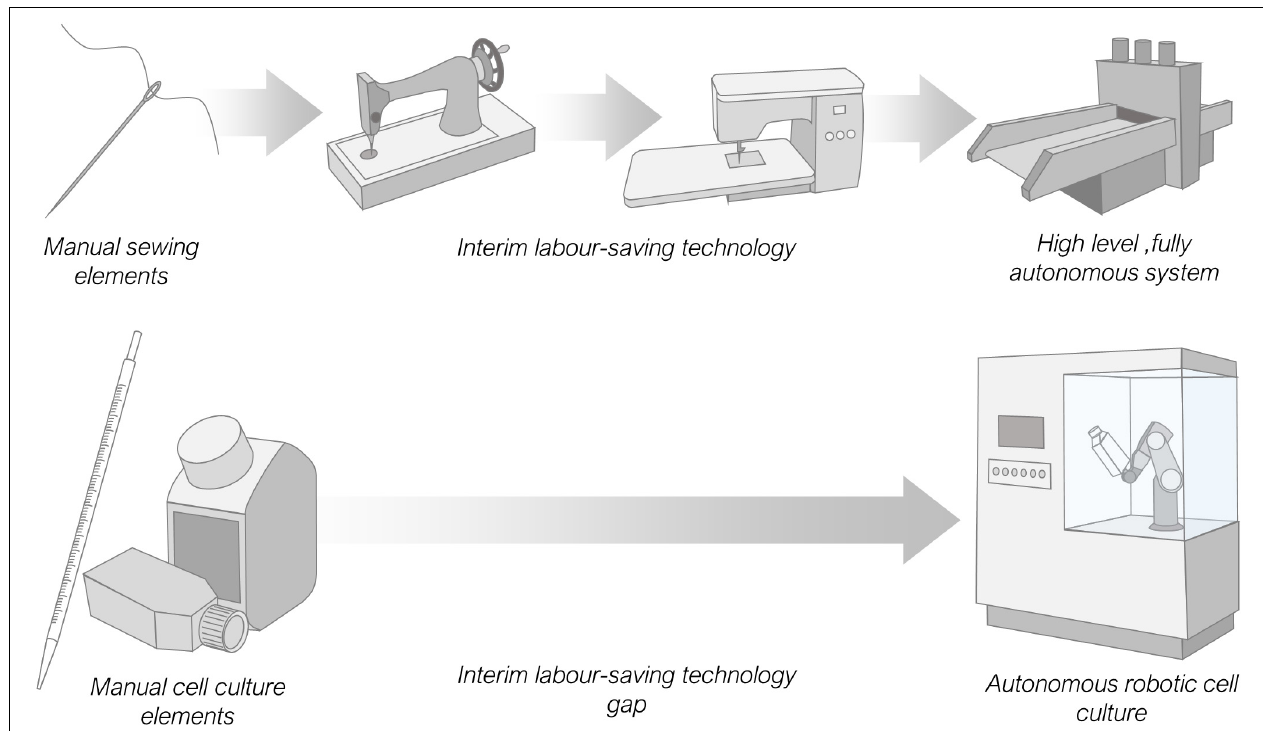
FIGURE 4 | Comparison of available labour-saving automation options for the manual intensive processes of sewing and cell culture. Sewing has a range of interim automation options up to fully autonomous systems. Cell culture by contrast has only high-level automation equipment and no interim low-cost analogues to replace or augment manual